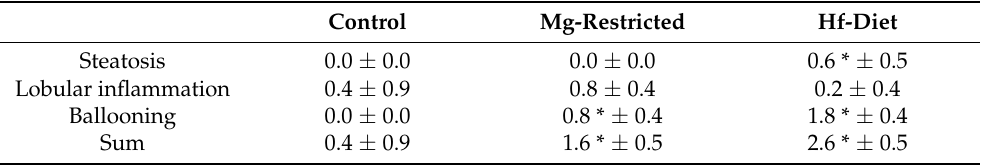
Figure 4. HE and oil red O stained liver sections of control, Mg-restricted, and HF-diet fed mice. To obtain an overall picture of liver histology, all liver sections of ( A ) control, ( B ) Mg-restricted, and ( C ) HF-diet fed mice are HE stained. Oil red O staining was performed to illustrate lipid accumulation in livers of ( D ) control, ( E ) Mg-restricted, and ( F ) HF-diet fed mice. Depicted are representative excerpts of the respective group (magnification 200), in which asterisks mark a central vein, black triangles heads mark inflammatory cell infiltration, and circles indicate enlarged hepatocytes, probably representing ballooning. The length of the scale bar in each picture is 100 µm. Additionally, all liver sections were histopathologically examined and scored as described in Section 4. The scoring of liver sections from Mg-restricted mice resulted in a numerically higher inflammation, ballooning, and sum score (Table 1). Steatosis, ballooning, and the respective sum score of HF-diet fed mice were statistically significantly elevated compared to control mice, while inflammation was not increased ( p < 0.05) (Table 1). Table 1. Histopathological feature scoring of steatosis, ballooning, and inflammation in livers of control, Mg-restricted, and HF-diet fed mice, expressed as medians and interquartile